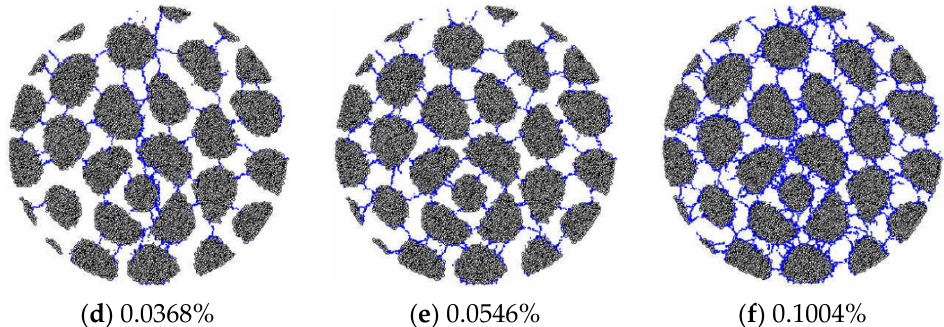
Figure 8. Microcrack morphology in the failure state of RC20 specimen.